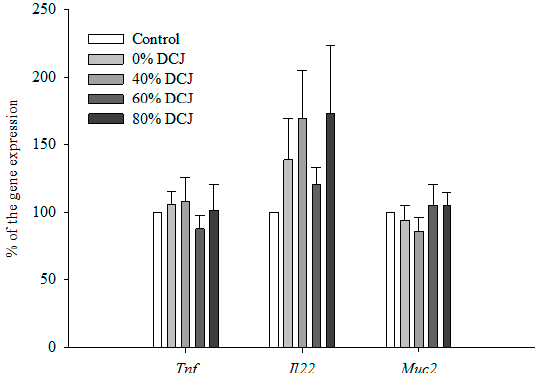
Figure 2. Effect of the deacidification of CJ on the expression of Tnf , Il22 , and Muc2 . Results are presented in % of the gene expression ± SEM compared to the control ( n = 12). A Student’s t test was performed to evaluate the differences between the treated groups and the control group.